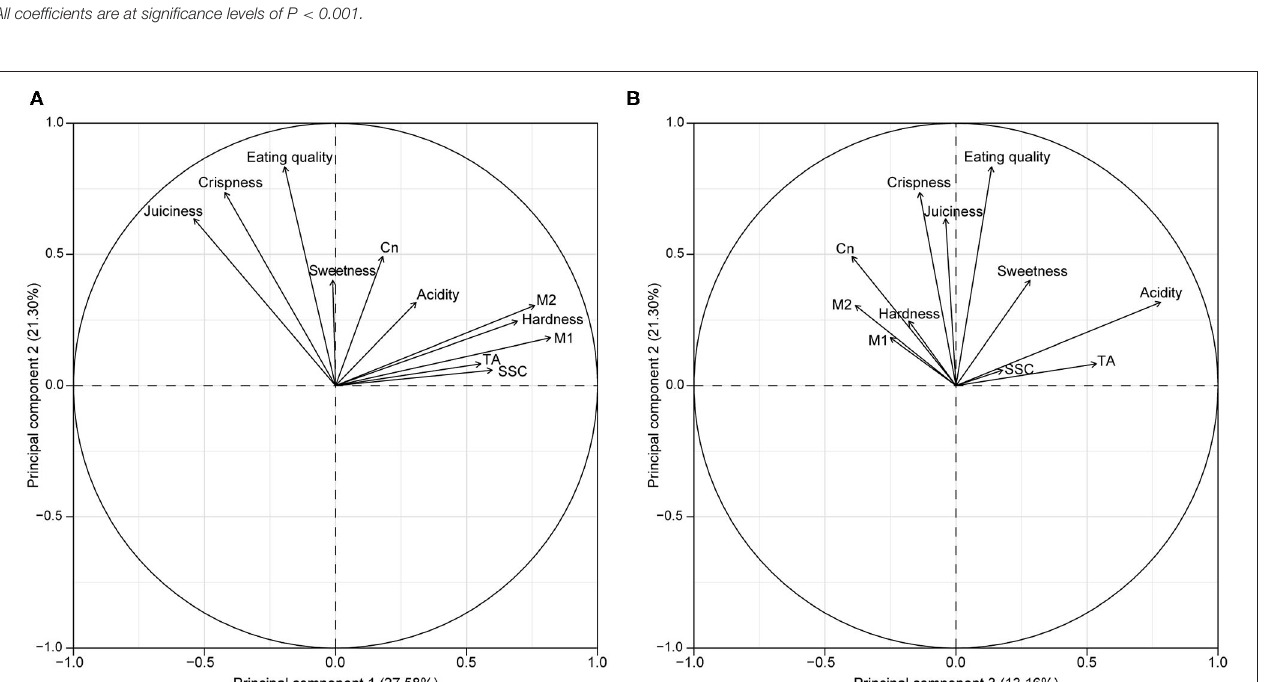
Frontiers in Plant Science |